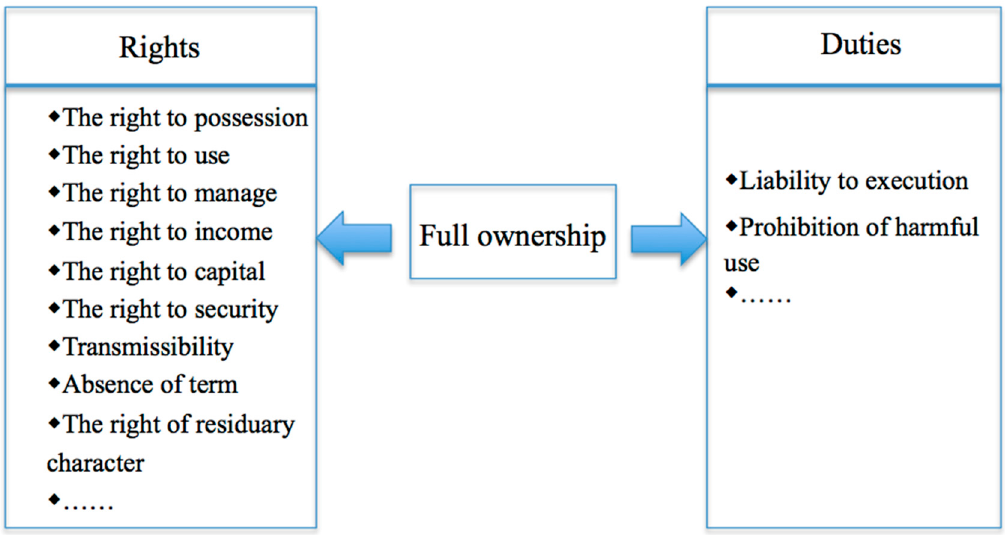
Figure 2. Rights and duties that regularly apply to the full ownership of land [27].